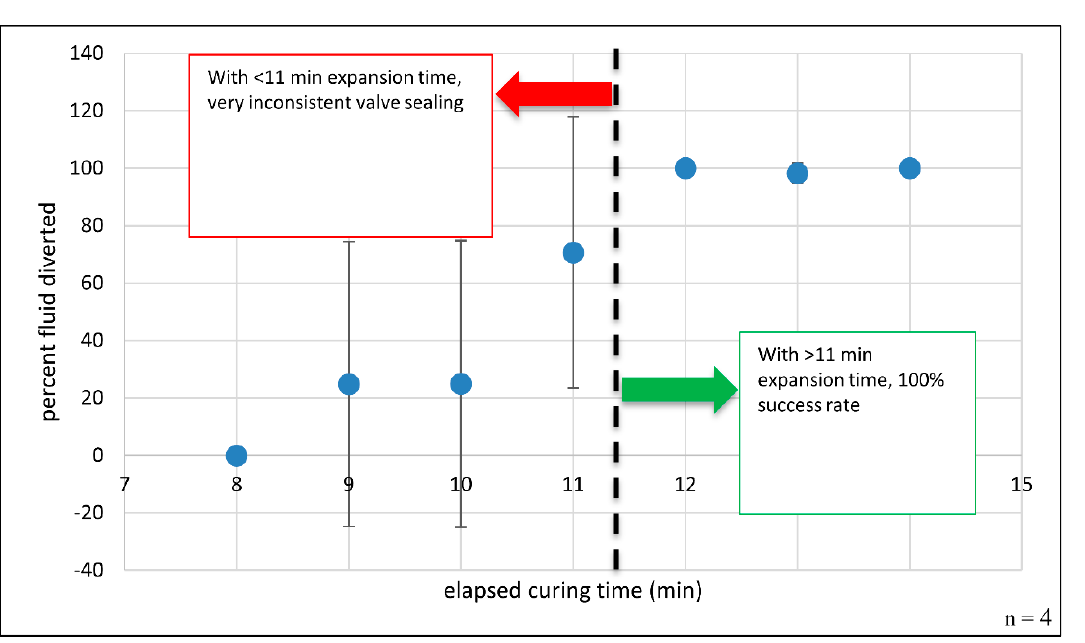
Figure 4. Blocking a channel with expanding polyurethane foam: Percent fluid diversion as a function of elapsed time. When the foam mixture was allowed to expand and cure for ≥ 12 min, 100% fluid diversion was observed. n = 4 attempted closures per time point. Note: When curing time > 11 min, the error bars are quite small and are not readily visible at 12- and 14-min time points.